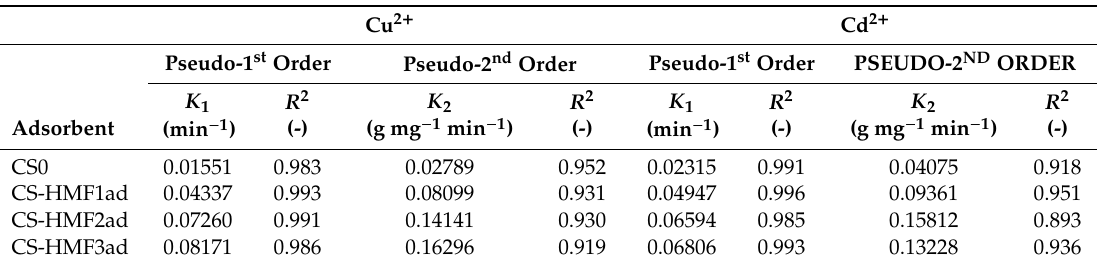
Table 1. Kinetic parameters for Cu 2 + ad Cd 2 + adsorption onto chitosan-HMF derivatives (fitting to PS1 and PS2 kinetic equations). Cu 2 + Cd 2 + Pseudo-1 st Order Pseudo-2 nd Order Pseudo-1 st Order